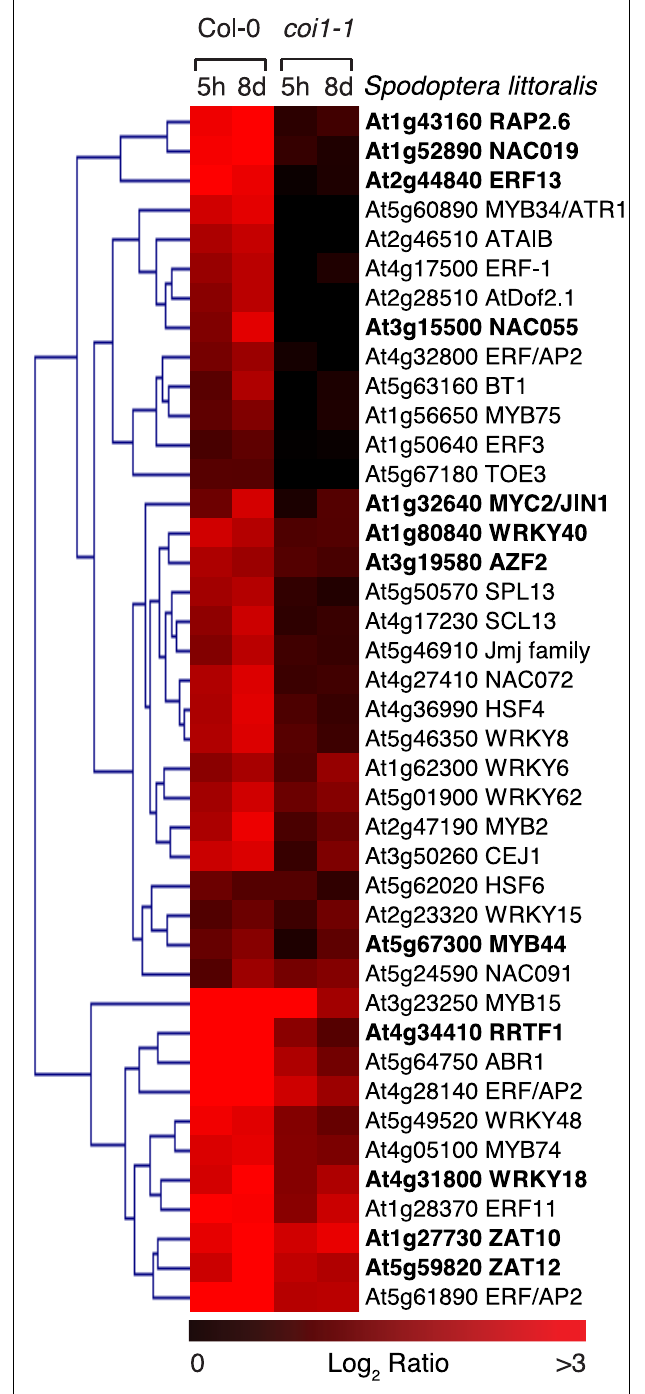
FIGURE 1 | Expression of insect-inducible transcription factors in wild-type and coi1-1 . Heat map representing transcription factors induced in response to Spodoptera littoralis in Col-0 and their expression in the coi1-1 mutant. Plants were challenged for 5h with fourth–fifth instar larvae or for 8days with first-instar larvae. Genes significantly induced (log 2 ratio > 1, P -value < 0.05) were represented in a clustered heat map with MultiExperimentViewer 4.8.1 using Euclidian distance. Genes in bold were analyzed in this study.